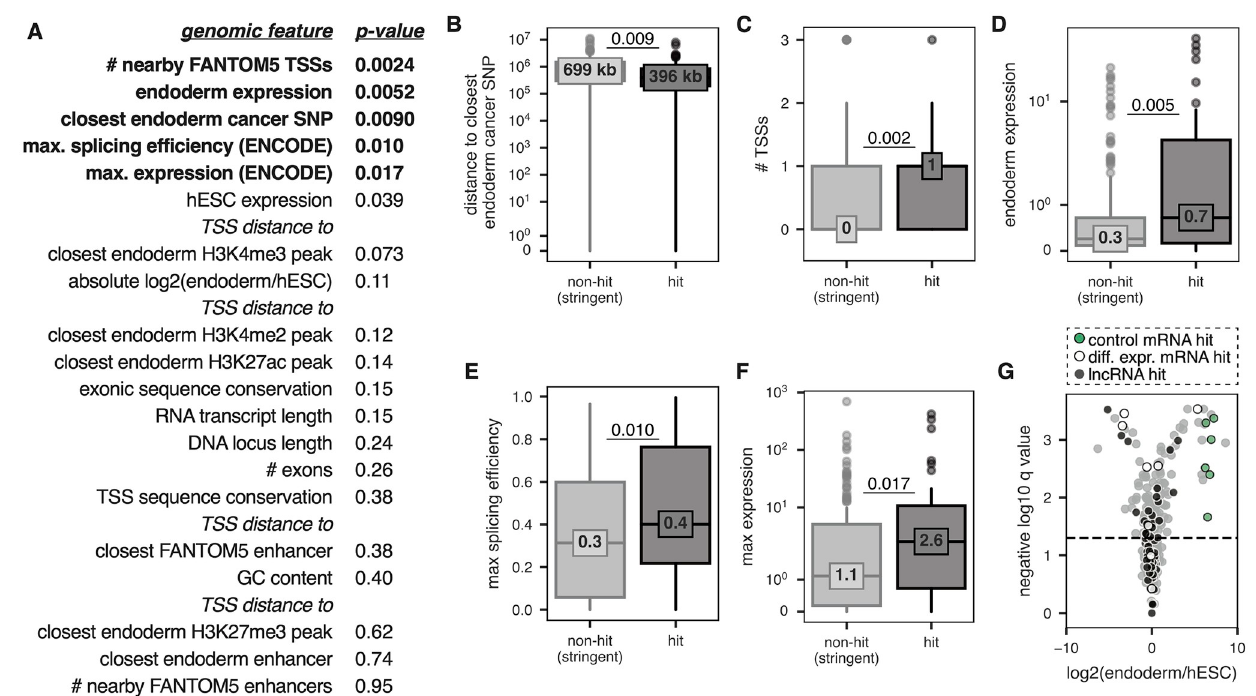
Fig 5. lncRNA hits are associated with certain genomic features. (A) List of genomic features analyzed and their associated two-sided Mann Whitney p- values comparing hit lncRNAs vs. stringent non-hit lncRNAs. Features with Benjamini-Hochberg adjusted FDRs of < 0.10 are shown in bold. (B-F) Boxplots showing the distributions of various genomic features outlined in (A) for hit lncRNAs and stringent non-hit lncRNAs. Median value of each distribution is also shown. P- values are from two-sided Mann Whitney tests. (G) Volcano plot showing the RNA-seq results for stringent non-hits (in gray, all biotypes) and hits (colored by biotype as shown above the plot). Horizontal line depicts an FDR cut-off of 0.05 for significant differential expression between endoderm and hESCs.